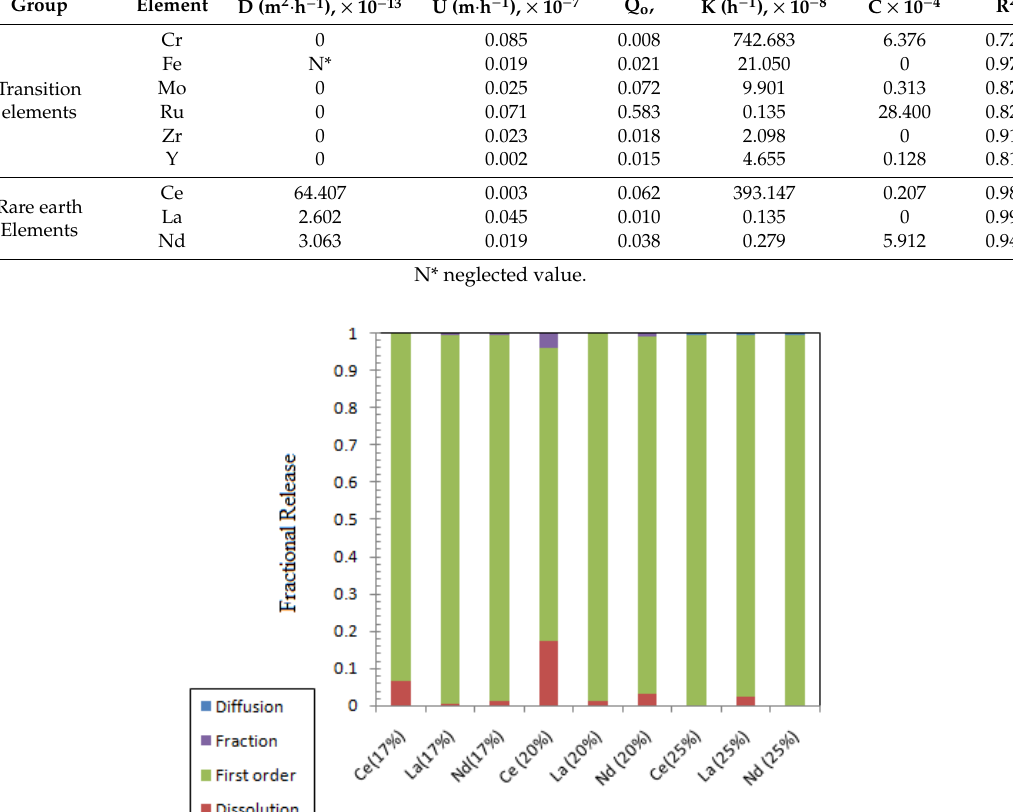
earth elements: ABS-Waste (25).